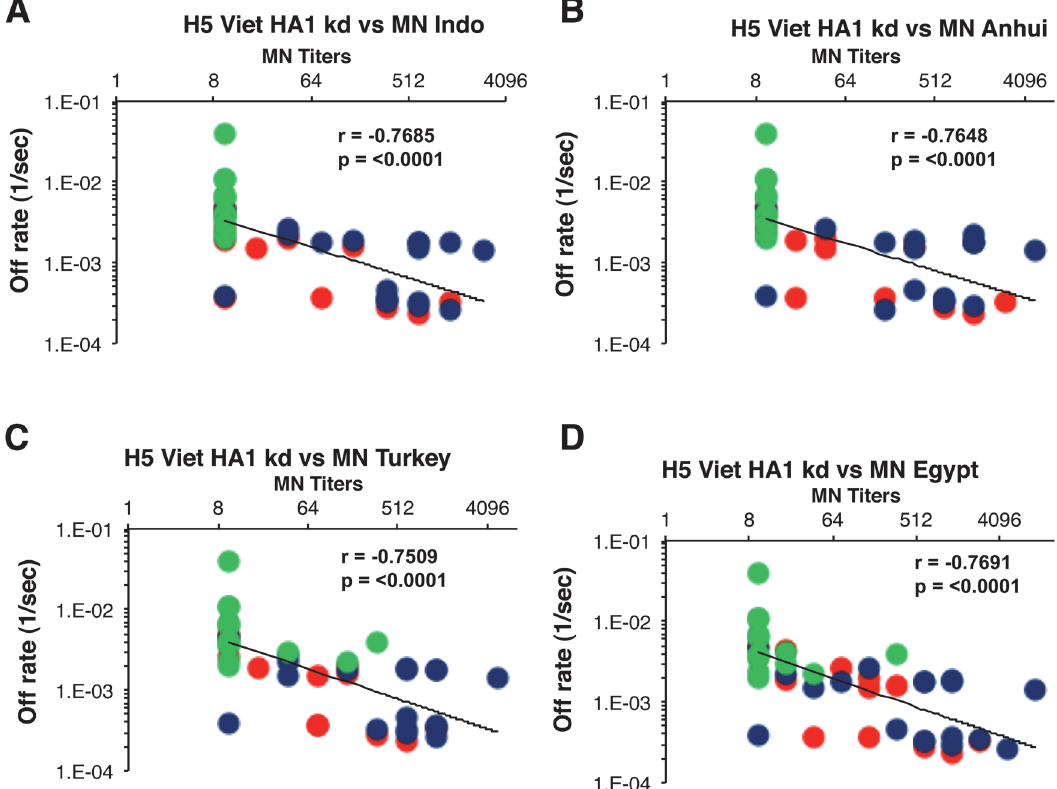
Fig 5. Serum antibody off-rates to H5-Viet-rHA1 following prime-boost strongly correlates with the in-vitro cross-neutralizing capacity against diverse H5N1 strains. End-point virus neutralization titers of samples collected after the H5N1 subunit vaccine boost are plotted on the X-axis. Antibody off- rate constants that describe the fraction of antibody-antigen complexes decaying per second were determined directly from the serum sample interaction with rHA1 protein using SPR in the dissociation phase are shown on Y-axis. Serum samples from low-dose Ad4-H5-Vtn primed (red circles), high-dose Ad4- H5-Vtn primed (blue circles) or unprimed (green circles) individuals following H5N1 subunit vaccination are shown. Antibody affinity of post-H5N1 vaccinated human sera against HA1 of H5N1-A/Vietnam/1203/2004 strongly correlated with the in-vitro heterologous MN titers against H5N1 clade 2.1- A/Indonesia/5/ 2005 (A), clade 2.3.4- A/Anhui/1/2005 (B), clade 2.2- A/Turkey/15/2006 (C), and clade 2.2- A/Egypt/NO3072/2010 (D). Spearman correlations are reported for the calculation of correlations between off-rate and MN titers combined across all vaccine groups.